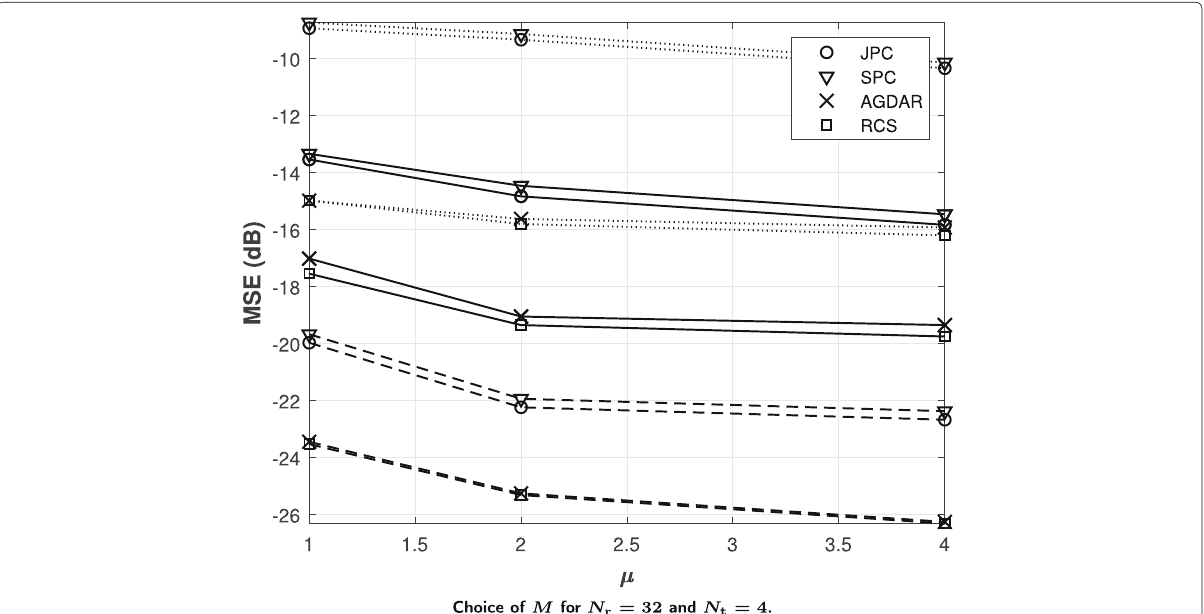
Fig. 6 Choice of M for N r = 32 and N t = 4. MSE vs μ for ULA with N r = 32 and N t = 4 at an SNR of 0 (dotted lines), 10 (solid lines) and 20 dB (dashed lines) and M 1 = μ N r and M 2 = μ N t . UMi LOS